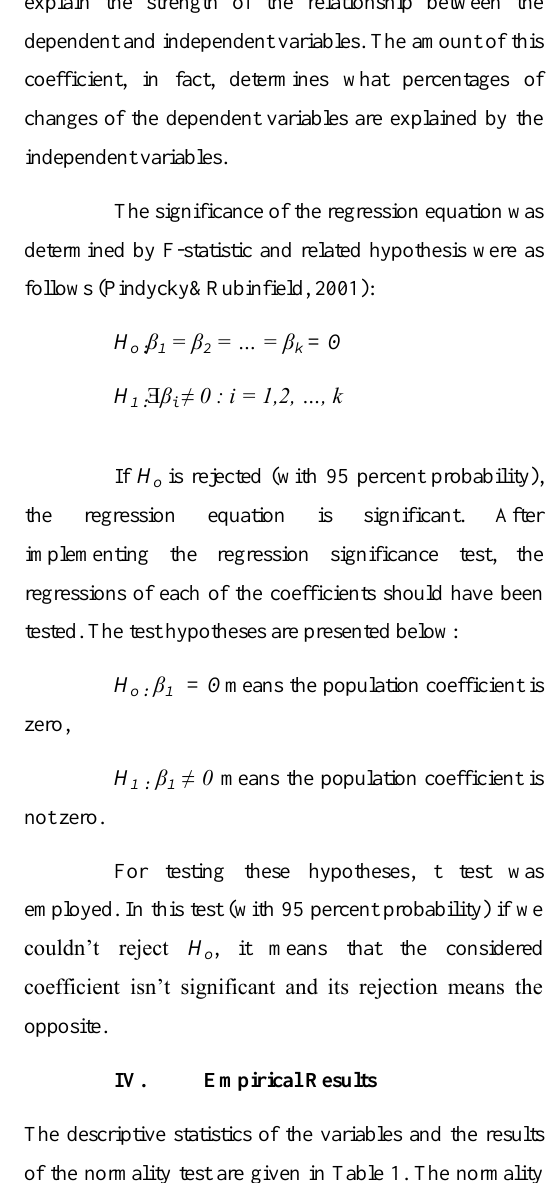
Table 1: Descriptive Statistics and Normality